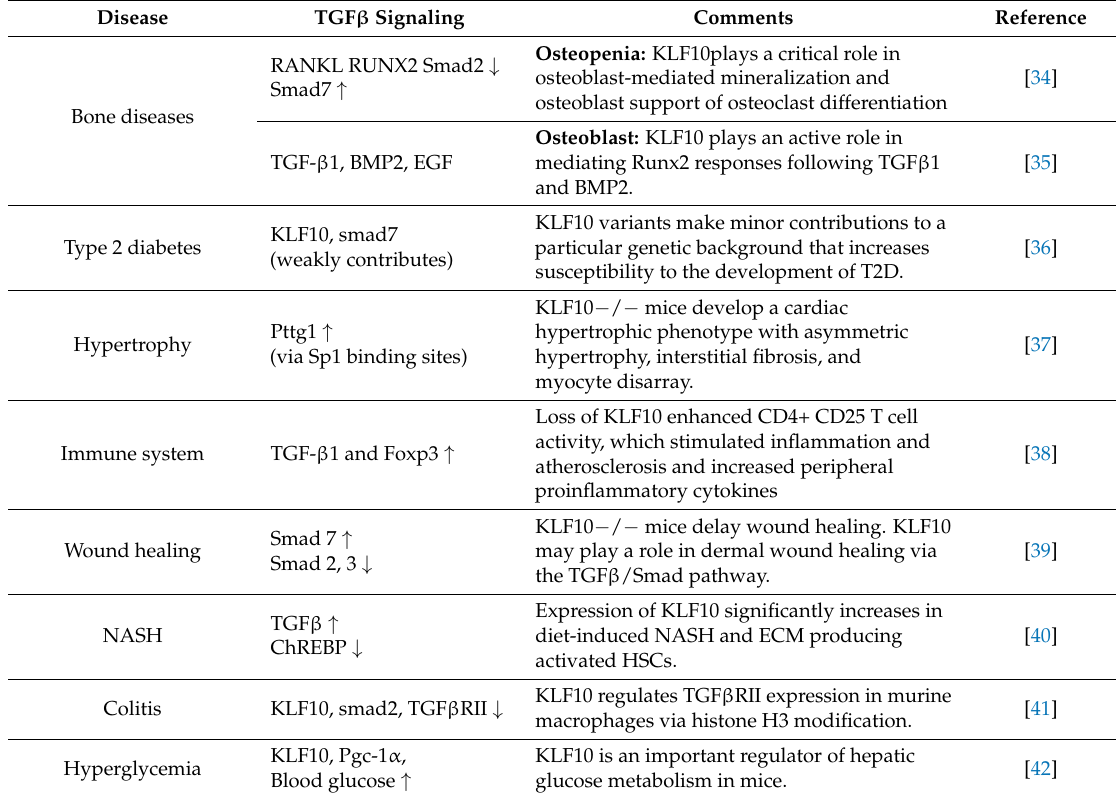
Table 2. KLF10 role in diseases other than